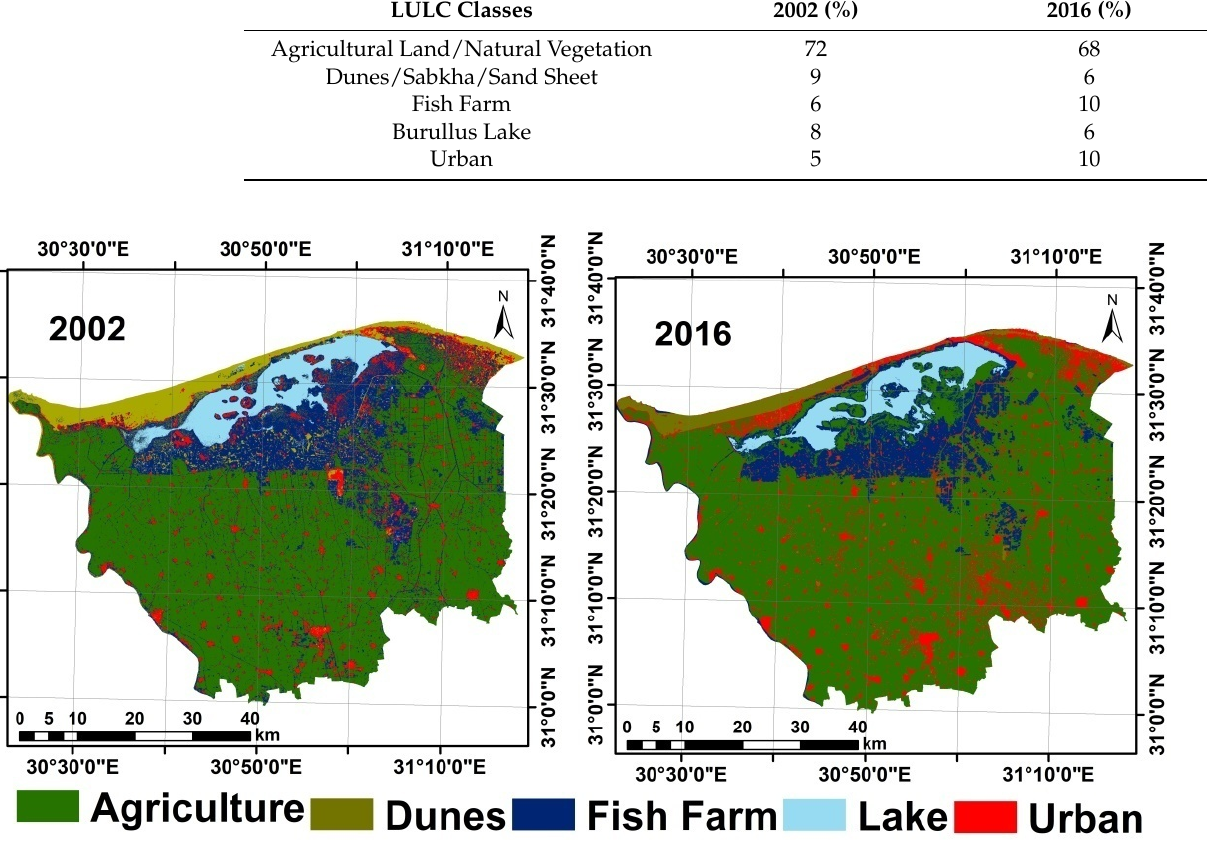
Table 4. The percentage of area coverage for LULC classes in 2002 and 2016.